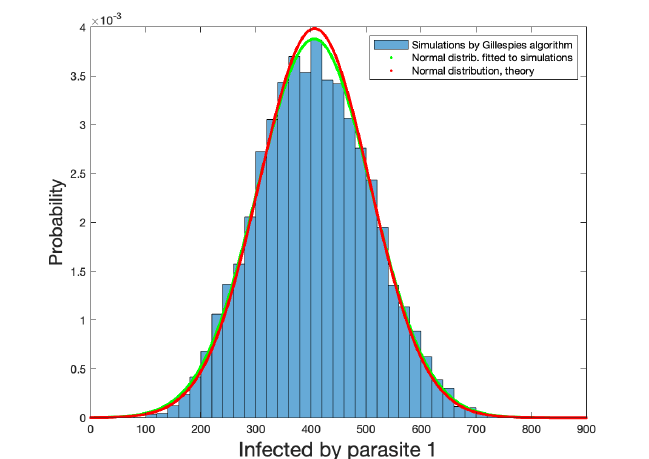
Figure 2. Histogram generated from simulations using Gillespie’s algorithm is compared to the probability density with mean and variance obtained from simulation using Gillespie’s algorithm and the probability density of normal distribution with mean and variance obtained from the theory of I 1 , infected by parasite 1 compartment at time = 300 of the stochastic model with quiescence. The initial population sizes of the model are; I 1 = 50,000, I 2 = 10,000, Q 1 = 5000, Q 2 = 5000. The parameters of the model are β 1 = β 2 = 0.05, Λ = 1000, d = 0.5, ν 1 = ν 2 = 0.3, γ 1 = γ 2 = 0.003, ζ 1 = ζ 2 = 0.1, ρ 1 = ρ 2 = 0.7, (cid:101) 1 = (cid:101) 2 =